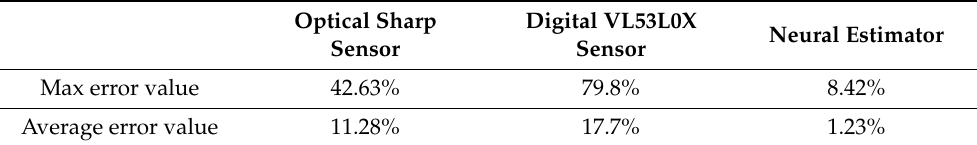
Table 2. Values of relative errors for the sensors and the estimator.